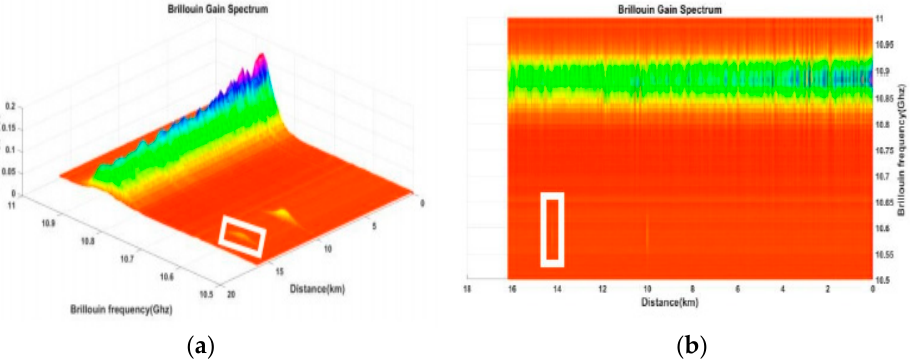
Figure 2. Analyses of Brillouin frequency versus fiber distance and optical output power using MATLAB software. ( a ) 3D graphic. ( b ) 2D graphic.